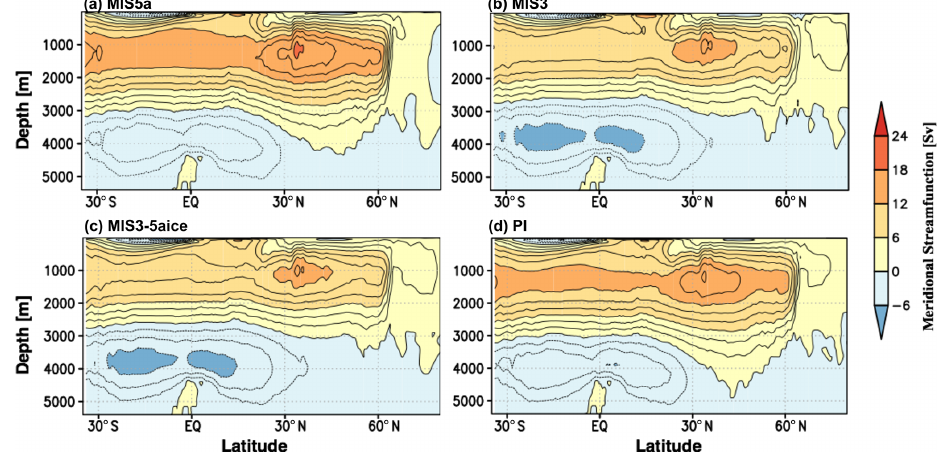
Figure 6. Meridional streamfunction (Sv = 10 6 m 3 s − 1 ) over the Atlantic simulated from the AOGCM. Panel (a) shows MIS5a, panel (b) shows MIS3, panel (c) shows MIS3-5aice, and panel (d) shows PI. The climatology of the last 100 years is used to create these